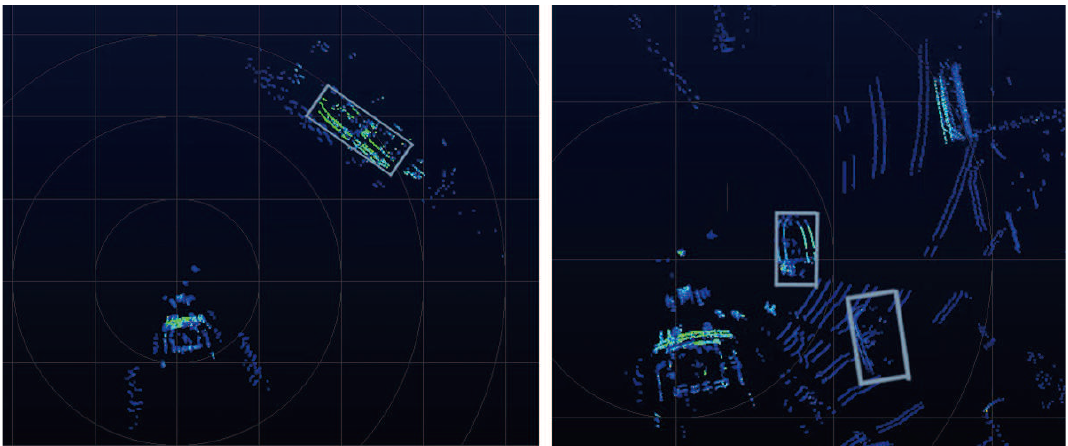
Figure 8. Object detection result: 3D boxes are projected to the BEV.